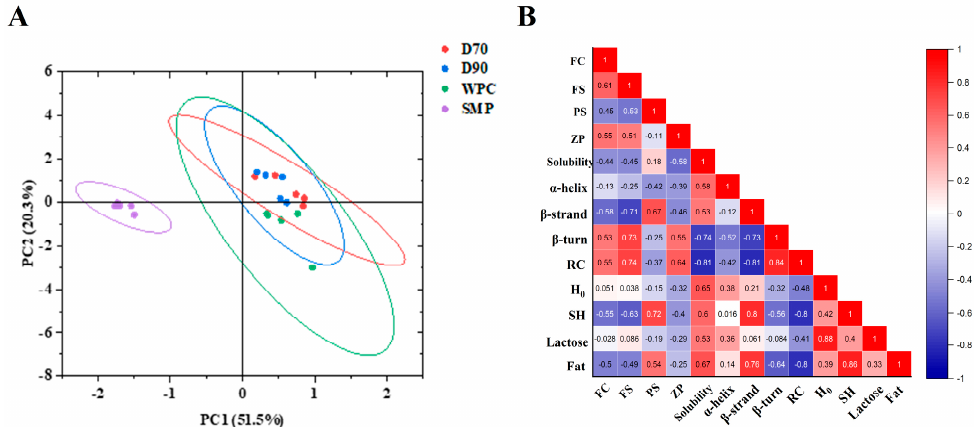
Figure 6. Principal component analysis score plot ( A ) and correlation analysis result ( B ) for D70, D90, WPC, and SMP samples. FC, foaming capacity (%); FS, foam stability (%); PS, particle size (nm); RC: random coil (%); H0, surface hydrophobicity; SH, free sulfhydryl content (µmol). The correlation between foaming and physicochemical properties was further ana- lyzed (Figure 6B). β -strand showed a negative correlation with FC/FS ( − 0.58/ − 0.71), while β -turn and random coil exhibited a positive correlation (0.53/0.73 for the β -turn and 0.55/0.74 for the random coil). SH content was negatively correlated with foaming prop- erties, which was consistent with Zhang et al., who reported that the improvement in